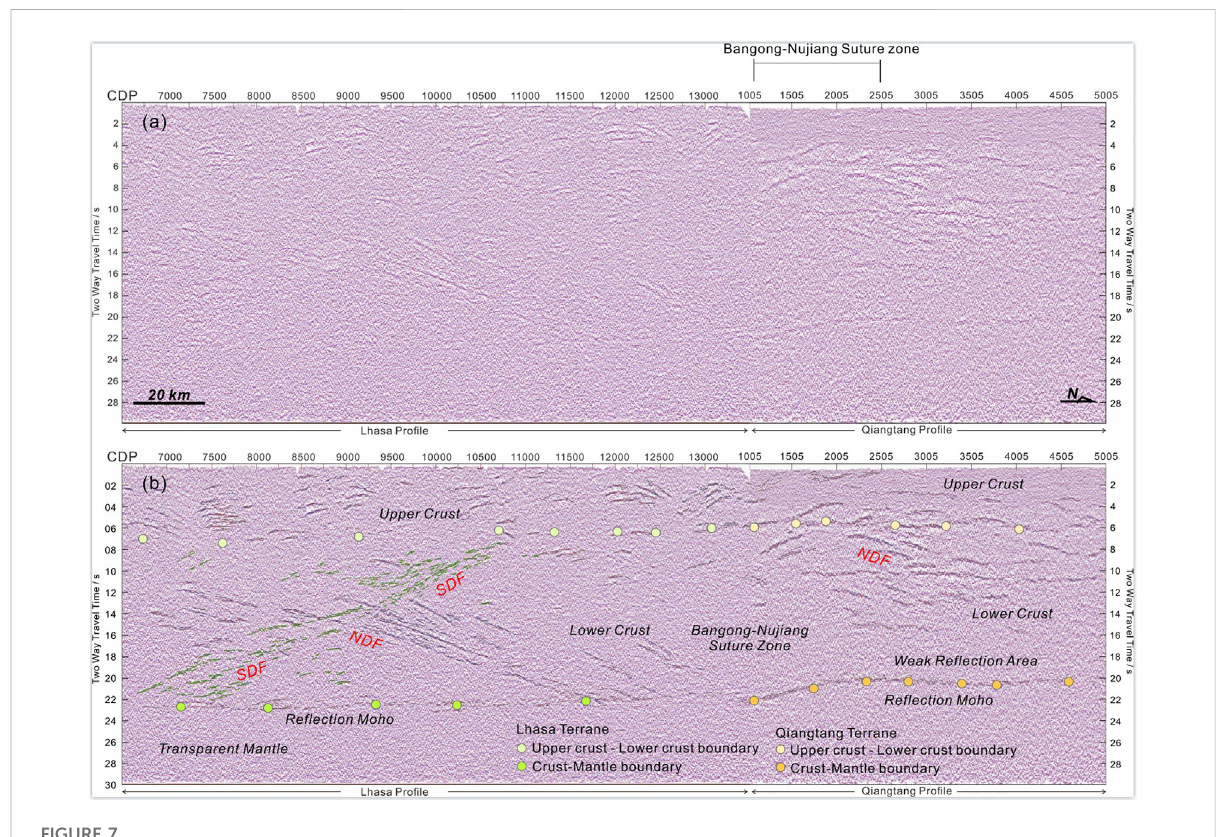
FIGURE 7 The deep seismic re fl ection result along the partial pro fi le (Shi et al., 2021); (A) : migrated seismic re fl ection result (B) : Interpreted seismic re fl ection result; the Common Deep Point numbers (CDP) indicating the horizontal axis and two-way travel time indicating the vertical axis. SDF, south-dipping fabrics; NDF, north-dipping